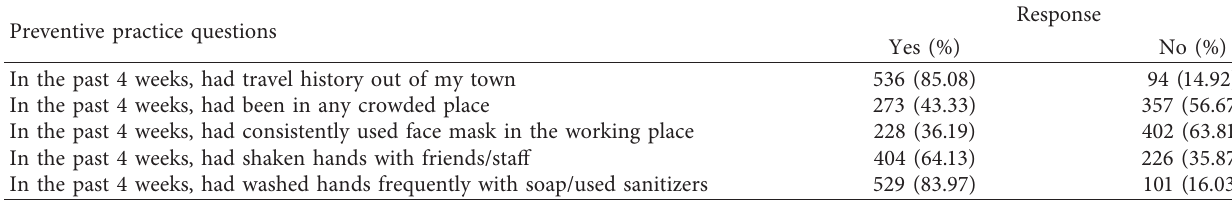
Table 1: Preventive practice of healthcare professions towards COVID-19.